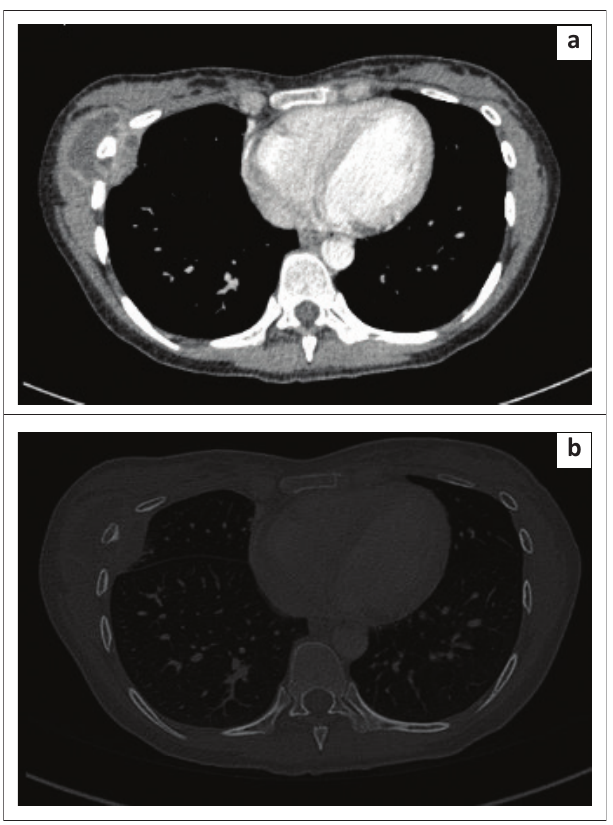
FIGURE 5: A 23-year-old female with swelling over the right chest wall. Post- contrast computed tomography axial soft tissue and bone window images (a, b) show a peripherally enhancing, hypodense soft tissue collection in the right chest wall with no obvious involvement of the underlying ribs or pleural cavity.